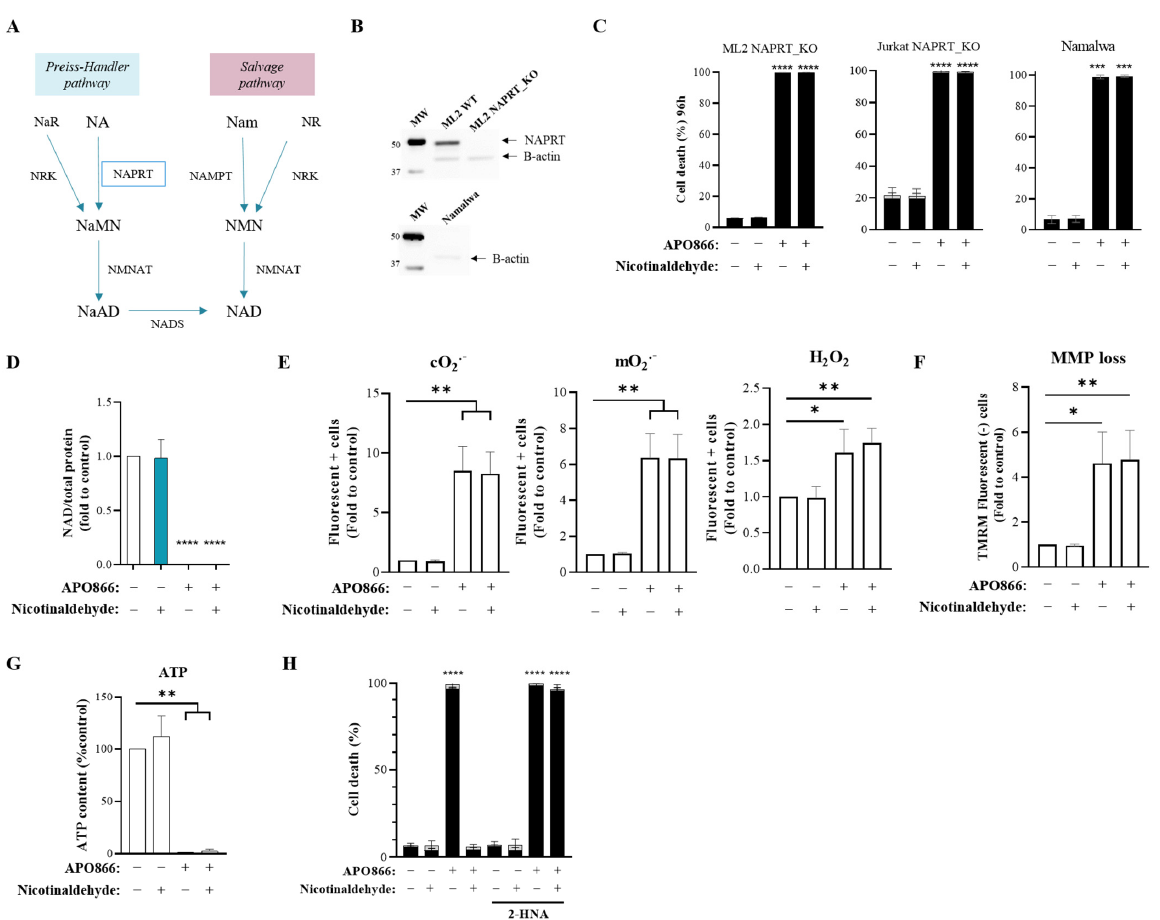
Figure 3. The nicotinaldehyde protective effect is dependent on NAPRT. ( A ) Schematic representa ‐ tion of major NAD biosynthetic pathways. Nam, nicotinamide; NR, nicotinamide riboside; NMN, Nam mononucleotide; NAMPT, Nam phosphoribosyltransferase; NRK, NR kinase; NMNAT, NMN adenylyltransferase; NA, nicotinic acid; NaR, nicotinic acid riboside; NaMN, NA mononucleotide; NAPRT, NA phosphoribosyltransferase; NADK, NAD kinase. ( B ) Western Blot images of NAPRT protein in ML2 WT, ML2 NAPRT KO and Namalwa cells. MW, molecular weight. ( C ) Cell death (black box = 7AAD + , late apoptosis and necrosis. Grey box = annexin V + 7AAD − , early apoptosis) of NAPRT ‐ lacking Jurkat NAPRT KO, ML2 NAPRT KO and Namalwa cells at 96 h of APO866 10 nM treatment. Uncropped Western Blots are available in Figure S7 ( D ) Intracellular NAD level in Jurkat NAPRT KO cells treated without or with APO866 (10 nM) in absence or presence of nicotinaldehyde supplementation (10 μ M) for 96 h. ( E ) Intracellular levels of ROS (cytosolic and mitochondrial O 2. ‐ and cellular H 2 O 2 measured with specific probes (DHE, mitosox and H2DCFDA). ( F ) MMP deter ‐ mined using flow cytometry, after cell staining with TMRM. ( G ) ATP concentration measured by luminescence assay and normalized to the protein concentration in untreated cells at the corre ‐ sponding time point. ( H ) Cell death at 96 h of ML2 cells treated without or with APO866 and nico ‐ tinaldehyde, in the absence or presence of 2 mM 2 ‐ hydroxynicotinic acid (2 ‐ HNA). Data are mean ± SD, n ≥ 3. * P < 0.05, ** P < 0.01, *** P < 0.001, **** P < 0.0001.